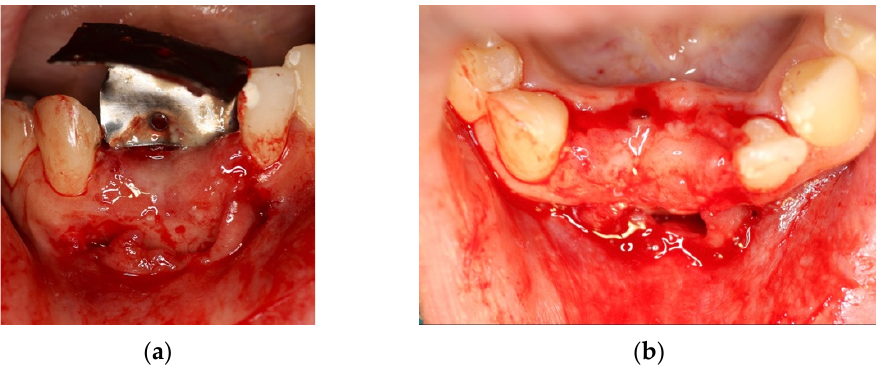
Figure 16. ( a ) Removal of titanium foil after 4 months; ( b ) osteoid tissue with hard but still elastic consistency covered by not-epithelized mucosa.